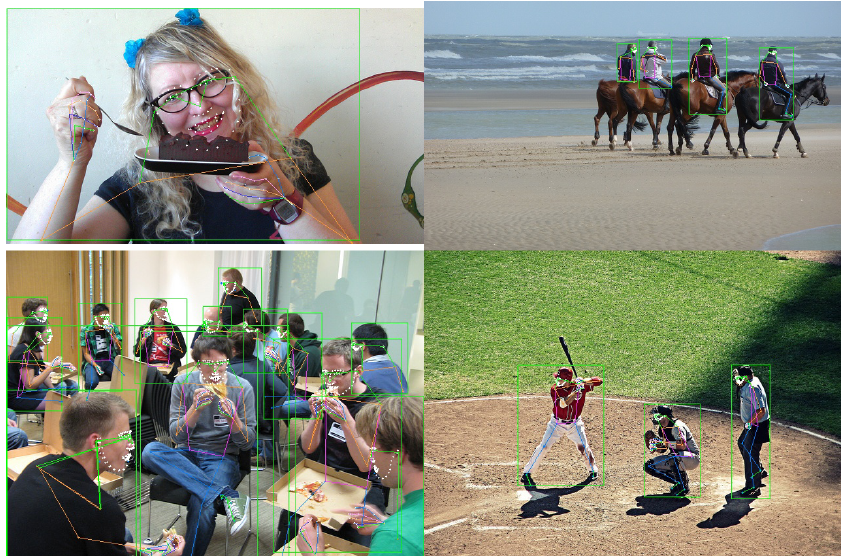
Figure 1. Full-body pose estimation examples with our Full-BAPose method showing a single person and multiple people at various scales and occlusions. The bottom-up approach determines the bounding boxes (in green) and the person pose